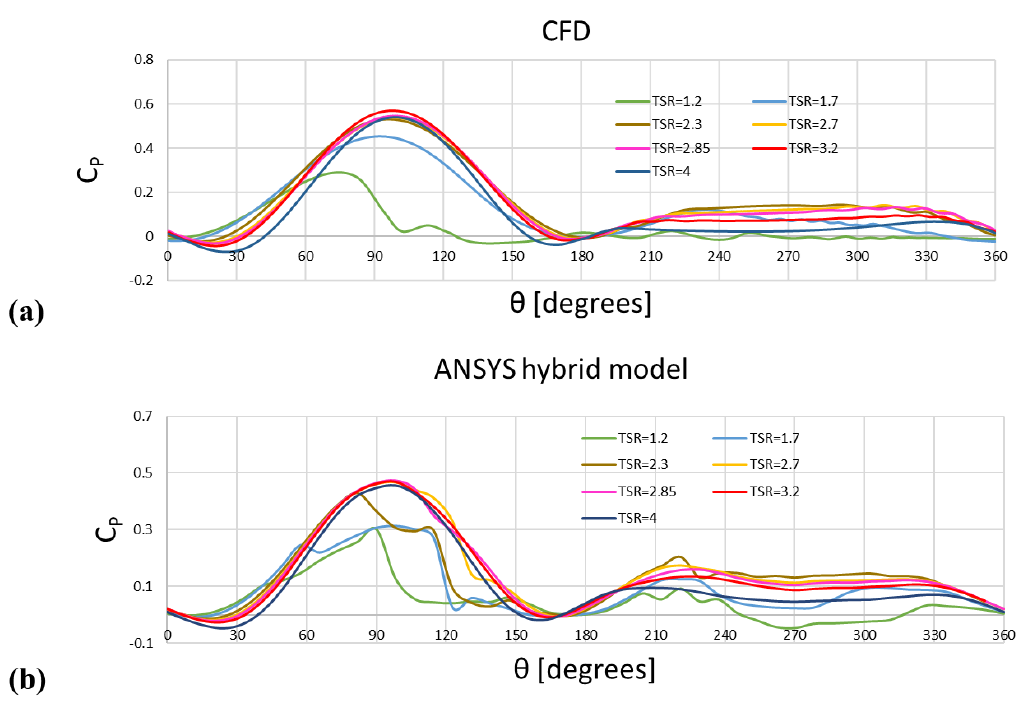
Figure 7. C P at di ff erent TSR for both pure CFD ( a ) and the ANSYS hybrid model ( b